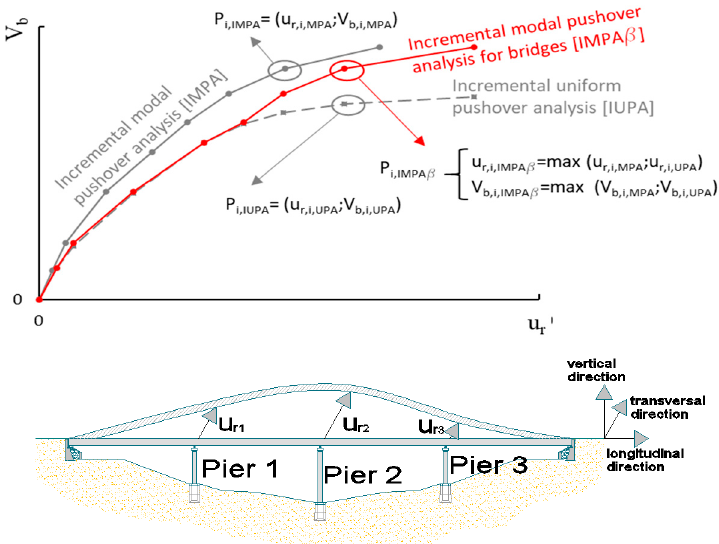
Figure 1. (Top) Degrees of freedom of the bridge: performing a pushover analysis the displacement u r of the control point (u r is the transversal displacement). (Bottom) Procedure for the definition of the capacity curve of the incremental modal pushover analysis for bridges (IMPA β ) as an envelope of uniform pushover analysis (UPA) and modal pushover analysis (MPA) at each intensity